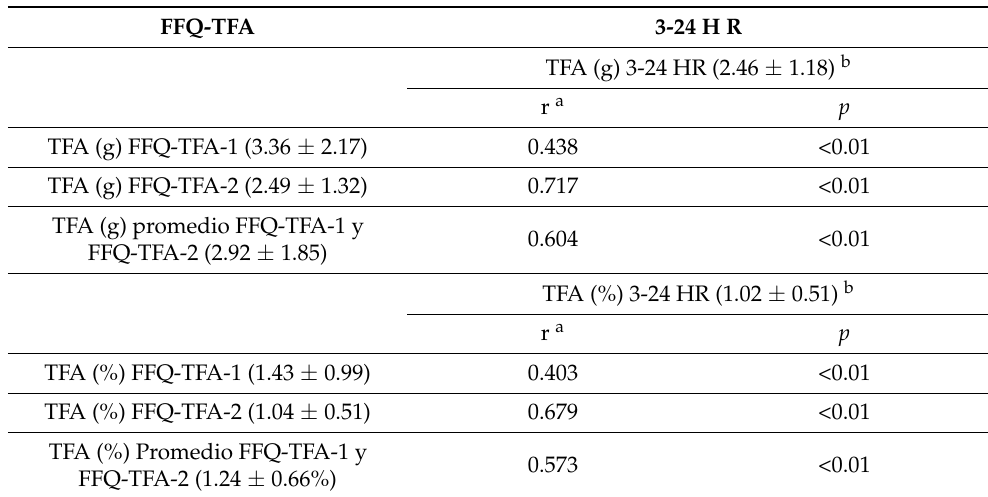
Table 3. Correlation between grams and percentages of TFA estimated by the 2 FFQ-TFA and the average of the 3-24 HR.